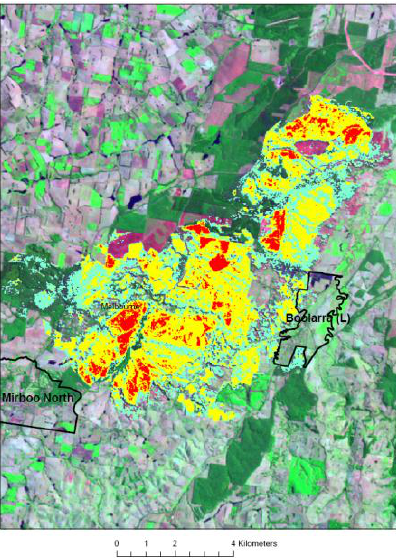
Figure 3. Delburn classified soil burn severity image. Light blue = Low, Yellow = Moderate, and Red =